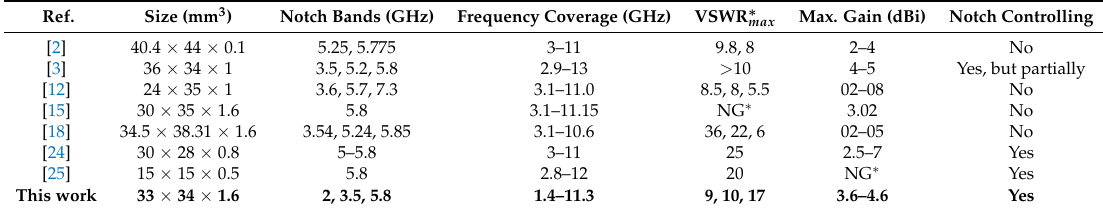
Figure 12. Group delay and transfer function of the triple band-notched UWB antenna. The proposed UWB antenna is compared with state-of-the-art UWB antennas in Table 2. Table 2. Comparison with previously published